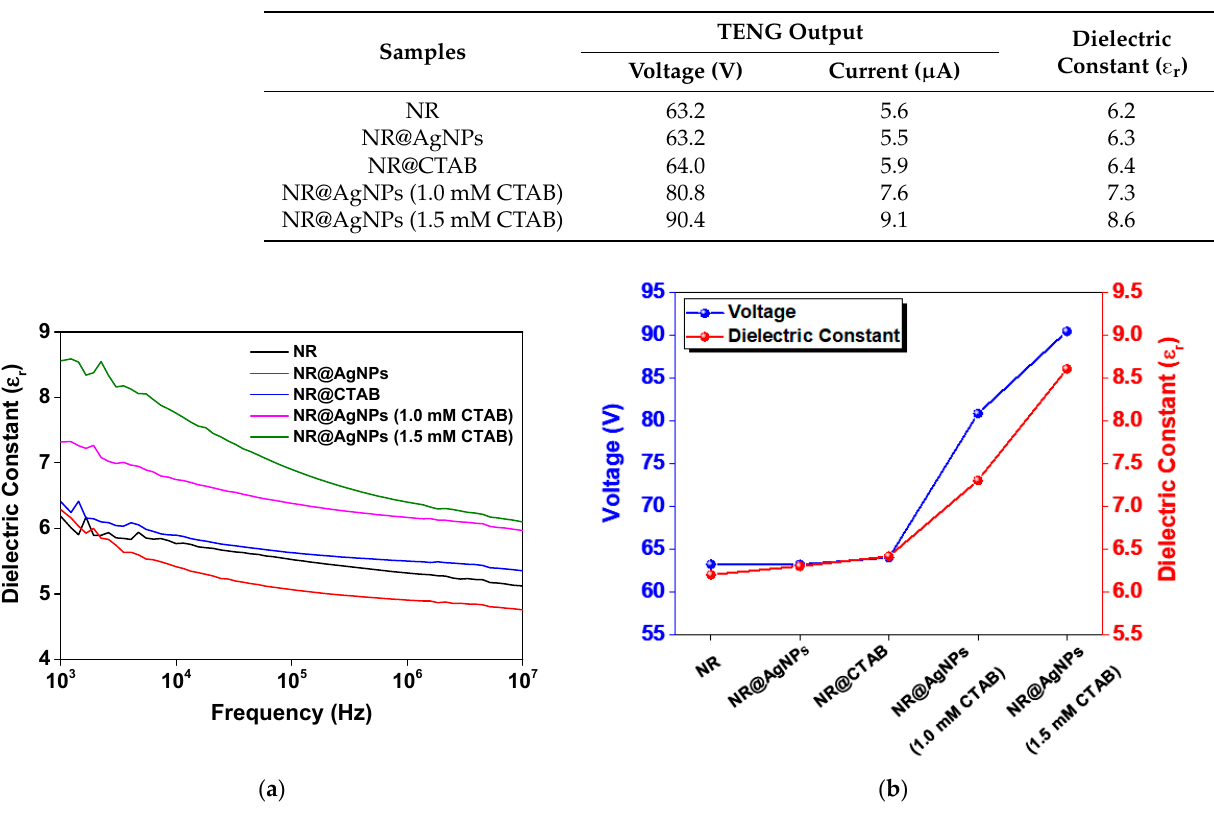
Figure 7. ( a ) Dielectric constant at various frequency ranges measured at room temperature and ( b ) the plot of TENG output voltage and dielectric constants of NR, NR@AgNP (without CTAB), NR@AgNP (1.0 mM CTAB) and NR@AgNP (1.5 mM CTAB) materials.